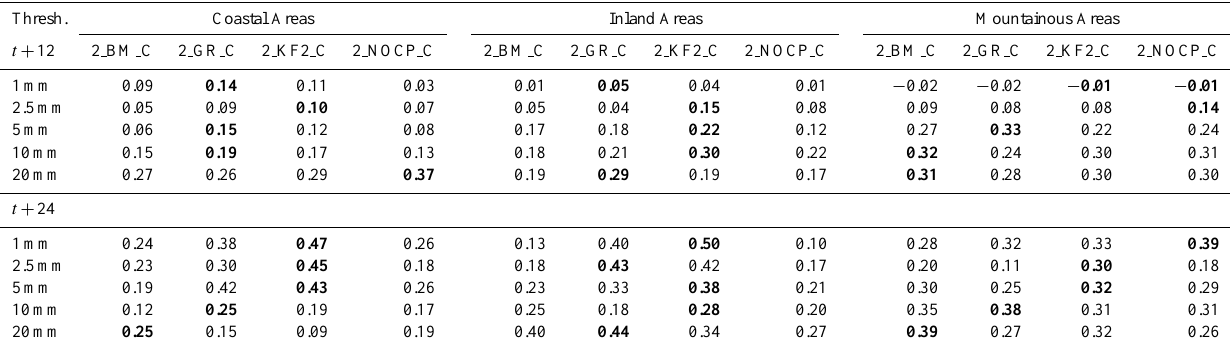
Table 12. As in Table 10 but for Equitable Threat (ET) score ( − 1/3–1). Thresh. Coastal Areas Inland Areas Mountainous Areas